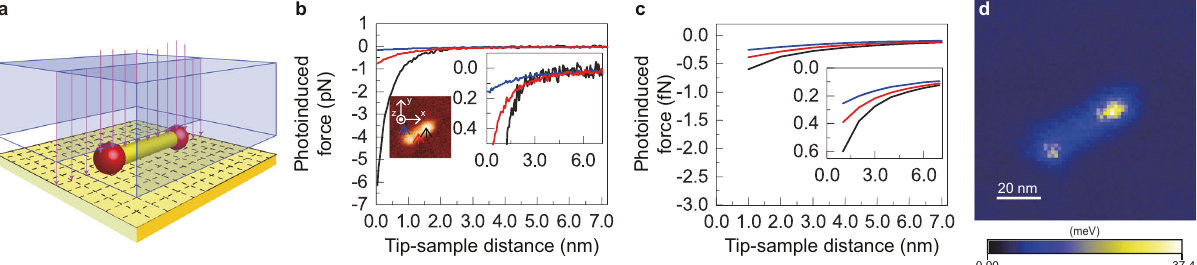
Fig. 3 3D force fi eld mapping of the photoinduced force. a Model of the ZAIS QD on gold during the measurement. b Force curves ( Fz pif − Δ z ) of the photoinduced force at the end of ZAIS QD, in the middle of the QD, and on the gold fi lm as recorded in the mapping with a controlled tip – sample distance ( Δ f = − 28 Hz, A = 10 nm, and λ = 660 nm). The inset image indicate the sites where the force curves are measured. c Theoretically calculated force curves for the photoinduced force. The force curves shown in the insets in b and c are the zoomed-in version of the graphs shown in the sub fi gure. d Interaction potential at Δ z = 0.0